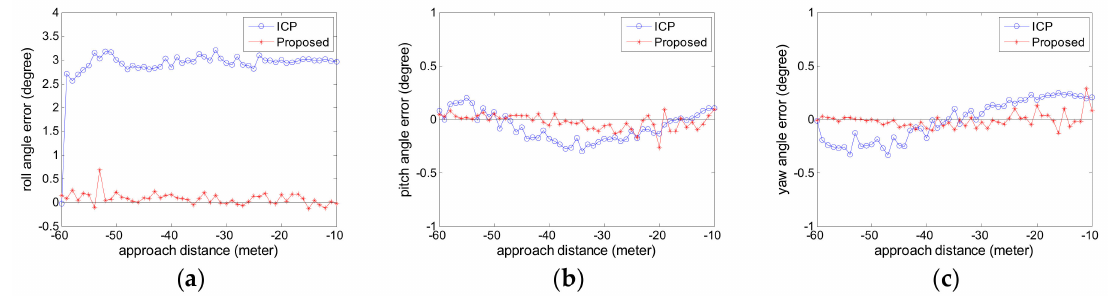
Figure 7. The attitude error curve in Experiment 1 ( a ) roll angle error; ( b ) pitch angle error; ( c ) yaw angle error.